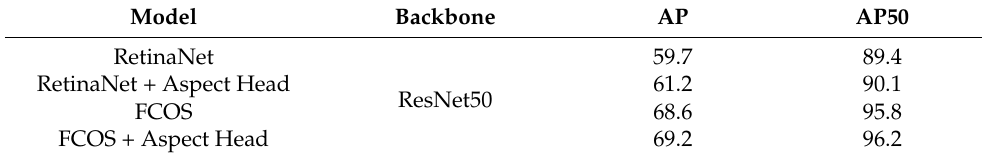
Table 4. Effectiveness experiment for the aspect-aware head for different models on